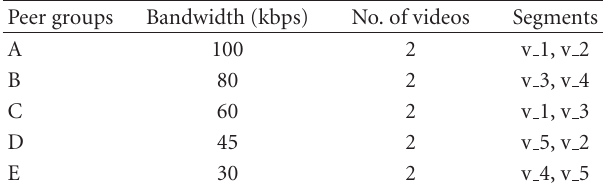
Table 6: Segment distribution in t raditional P2P.